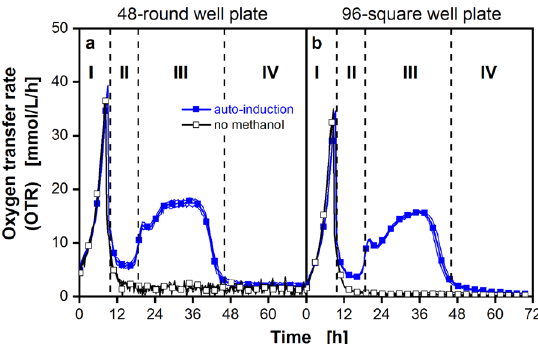
Figure 1. Cultivation of P. pastoris Mut S reference strain in two types of microtiter plates with simultaneous online monitoring of the oxygen transfer rate (OTR). Cultivation was carried out ( a ) in a 48-round well microtiter plate (MTP), 0.8 mL filling volume per well, operated at 1000 rpm and 3 mm shaking diameter in a µRAMOS/BioLector 32 combination device and ( b ) in a 96-square well MTP, 0.6 mL filling volume per well, operated at 350 rpm and 50 mm shaking diameter in a µTOM device 34 . The OTR at both MTP scales is depicted without methanol addition (black line), and with 2% (v/v) of methanol added to the medium at the beginning (t = 0 h) of the cultivation to obtain auto-induction conditions (dark blue line). The data was obtained in N = 2–6 replicates. Shadows symbolize the standard deviation of cultivations for N ≥ 3. In both panels, for clarity, only every 8th data point is displayed. The OTR course for the cultures with auto-induction can be divided into 4 phases (I to IV) at both MTP scales, separated by vertical black dashed lines: Phase I: growth on glycerol until depletion, phase II: methanol adaption, phase III: methanol consumption phase and phase IV,